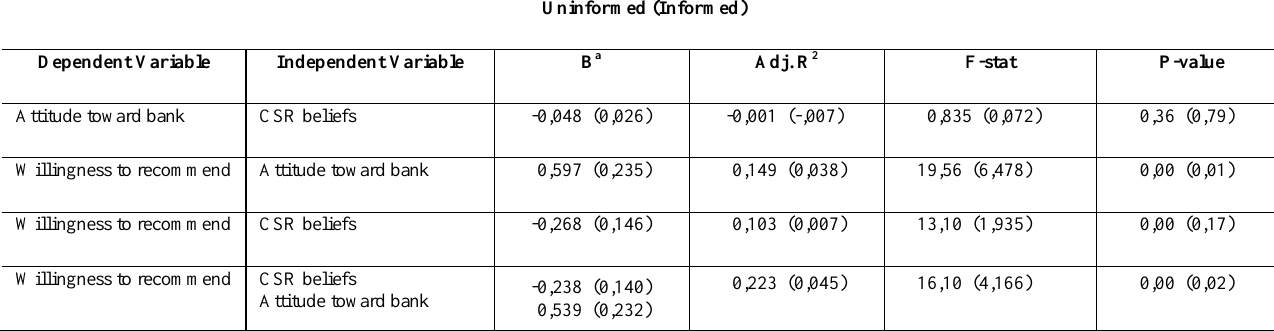
Table 6: Mediation regression